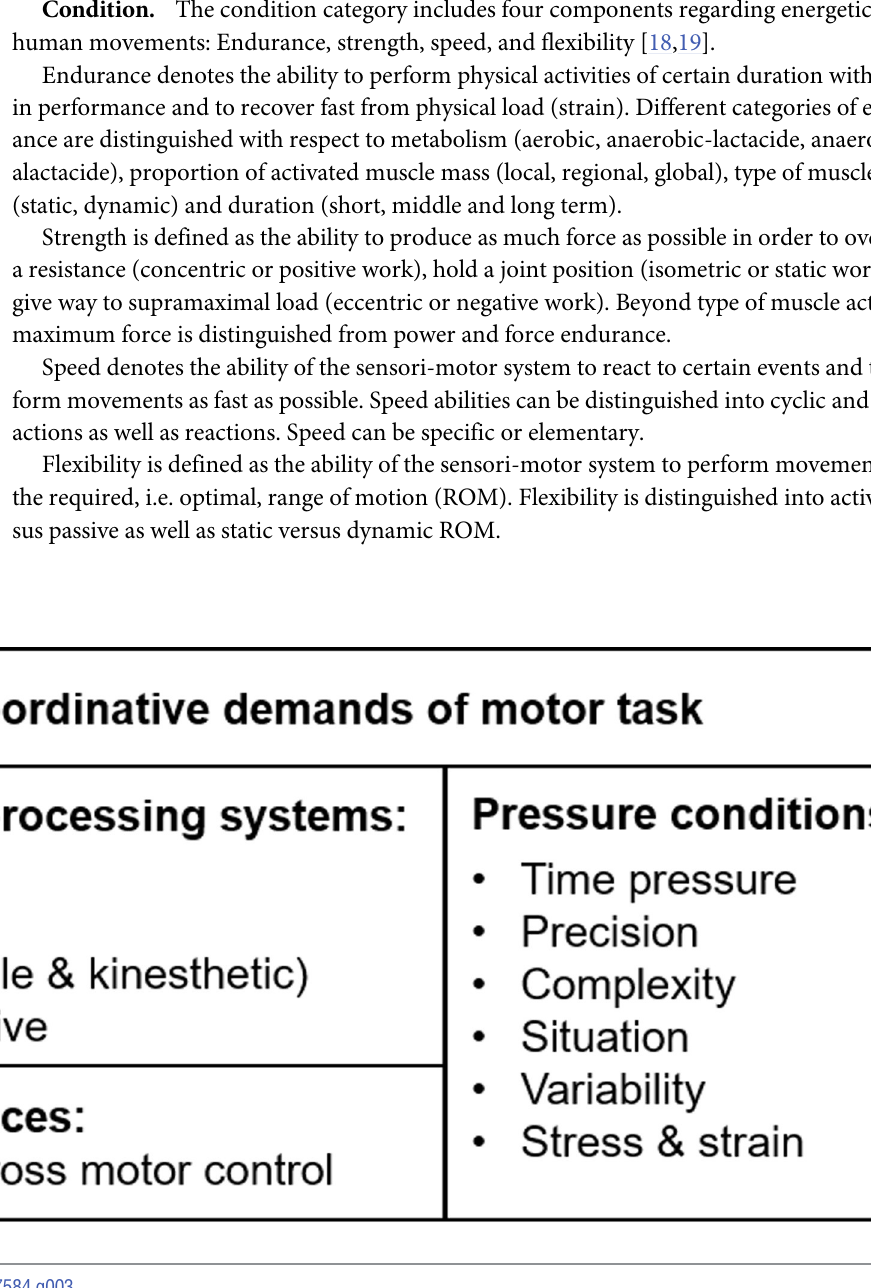
PLOS ONE | https://doi.org/10.1371/journal.pone.0237584 August 25,